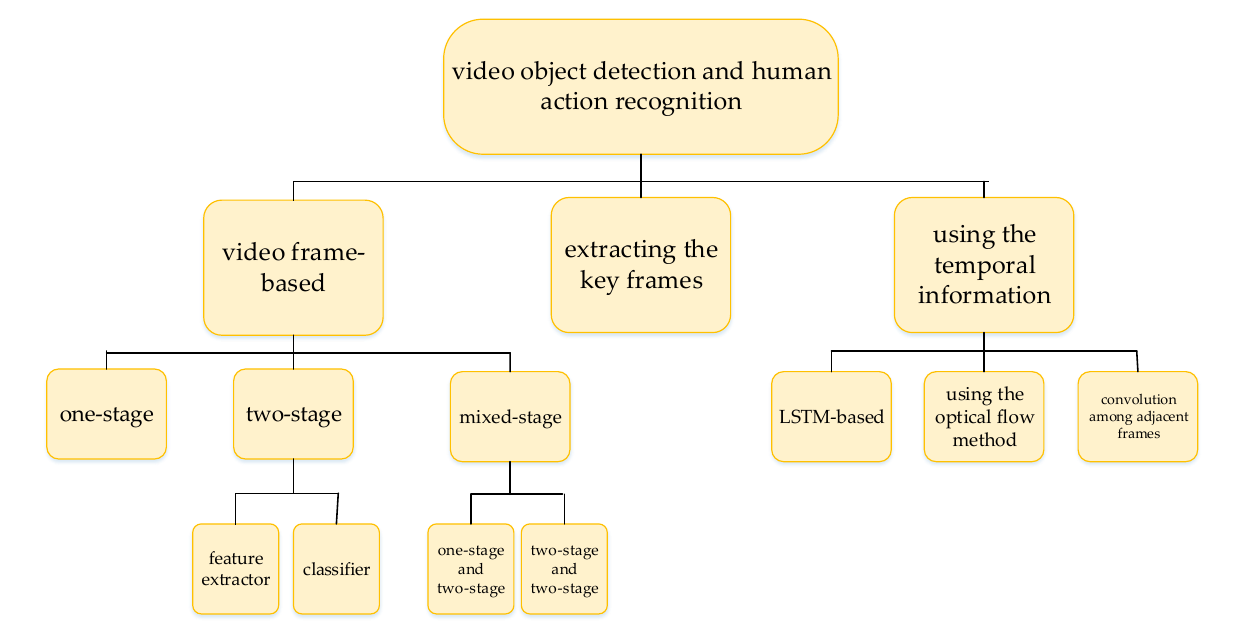
Figure 1. The summarization of video object and human action detection. The paper is organized as this structure as well.